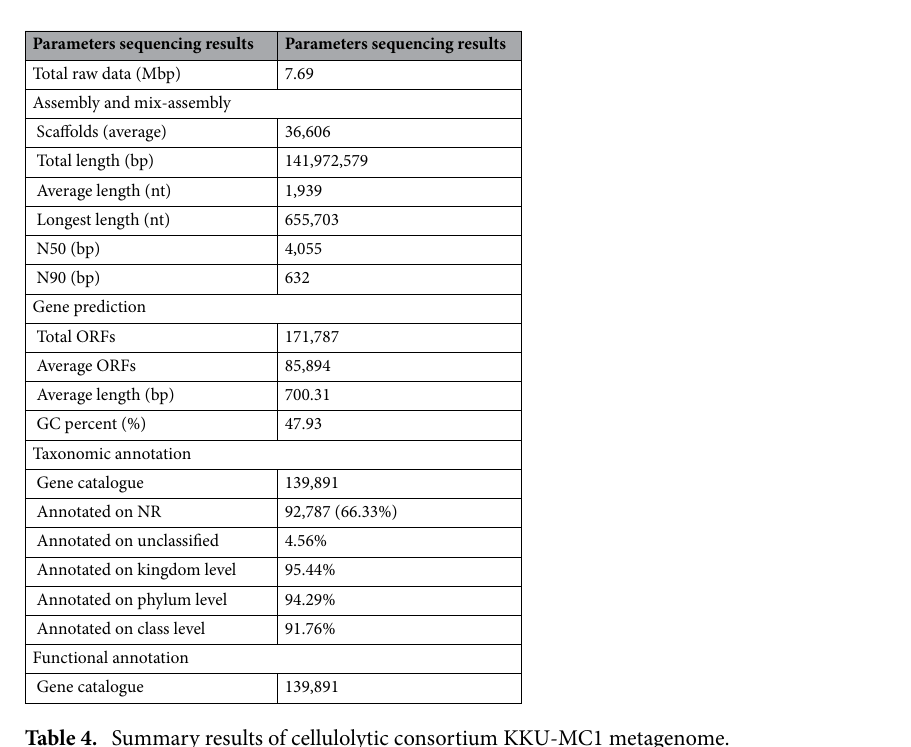
Table 4. Summary results of cellulolytic consortium KKU-MC1